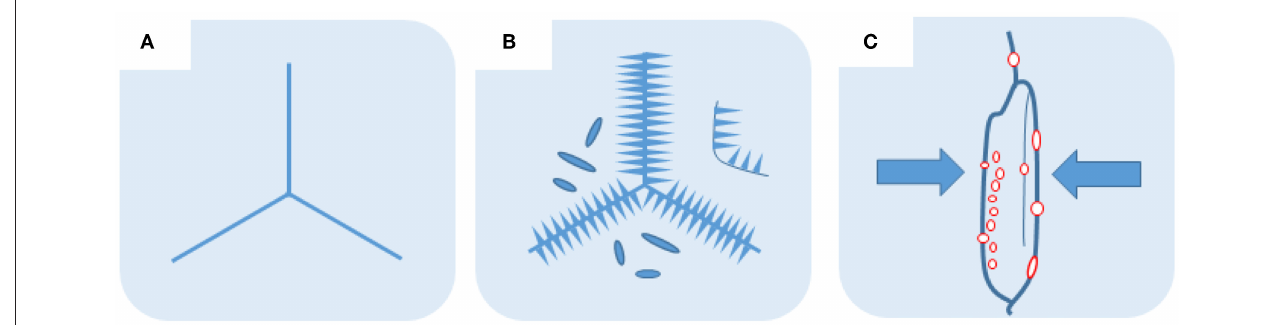
FIGURE 10 | Schematic diagram of the microstructure evolution of Ti-5.5Mo-6V-7Cr-4Al-2Sn-1Fe alloy under (A) solution treatment; (B) aging treatment and air cooling; (C) isothermal